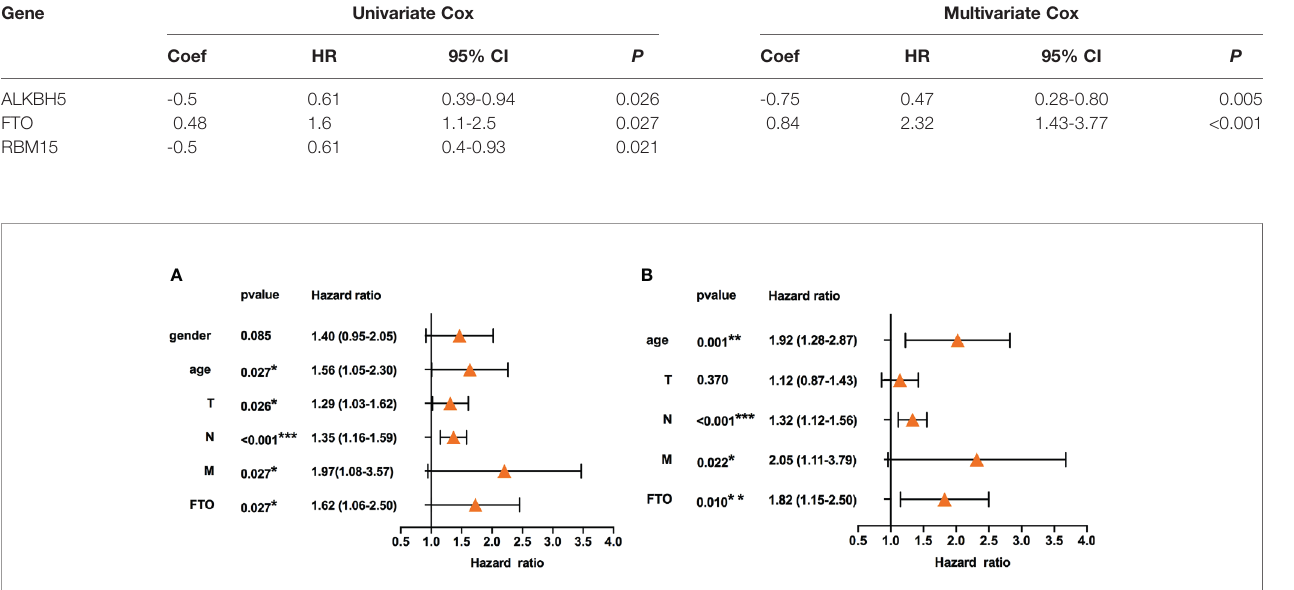
FIGURE 1 | High expression of FTO indicated poor prognosis in gastric cancer. (A) Univariate Cox regression analyses of the association between clinicopathological factors (including FTO) and overall survival of patients in the TCGA datasets. (B) Multivariate Cox regression analyses of the association between clinicopathological factors (including FTO) and overall survival of patients in the TCGA datasets. * P < 0.05, ** P < 0.01, and *** P < 0.001.